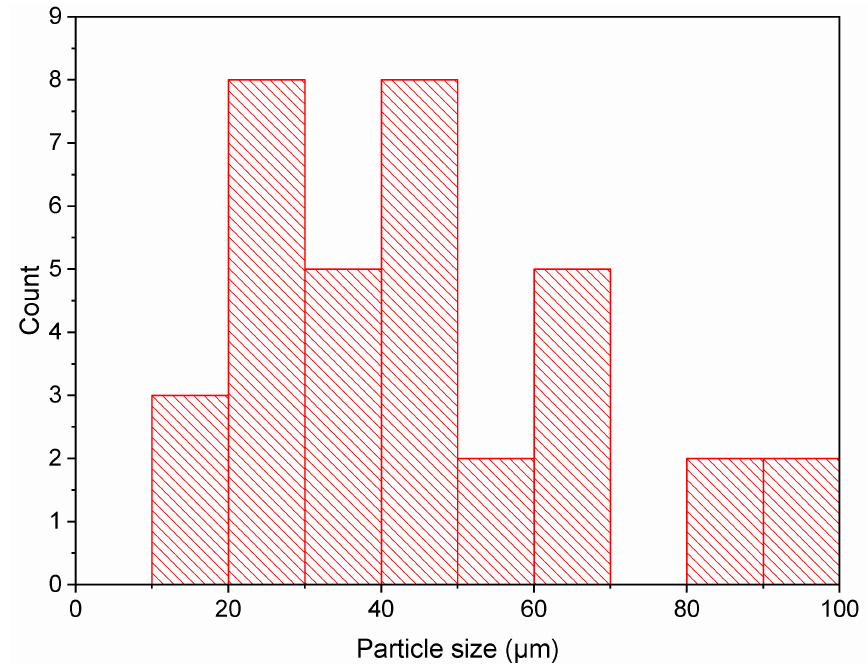
Figure 7. Particle size distribution.